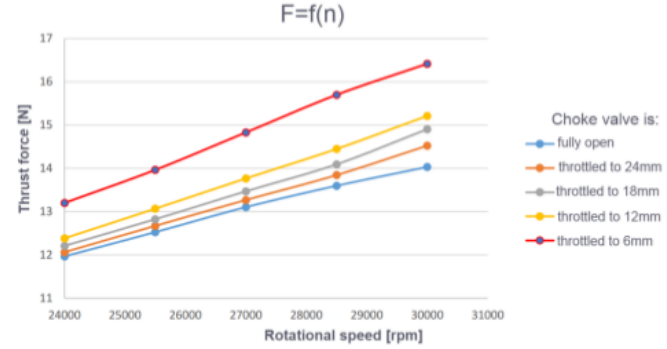
Figure 11: Force values measured during the test at different rotational speeds and different choke valve slot widths.